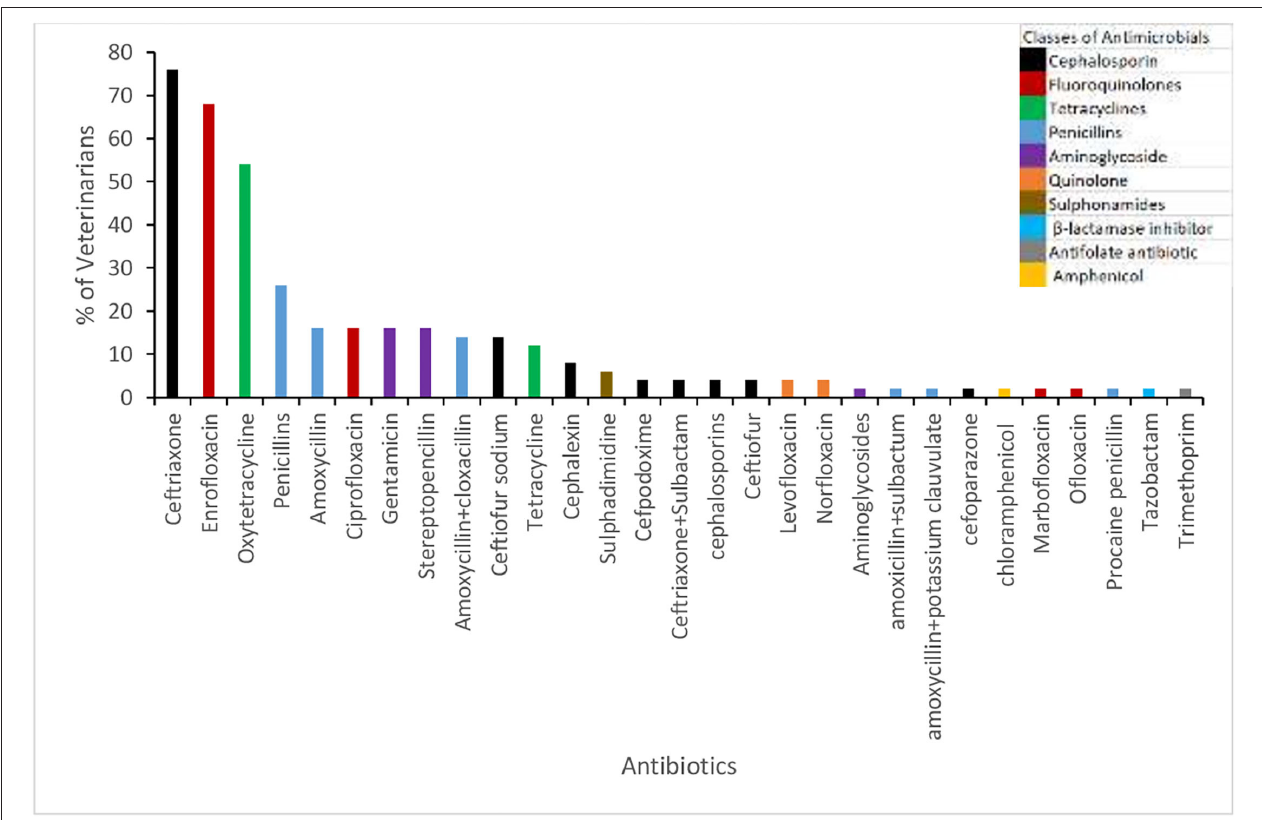
FIGURE 2 | Types of antibiotics prescribed by